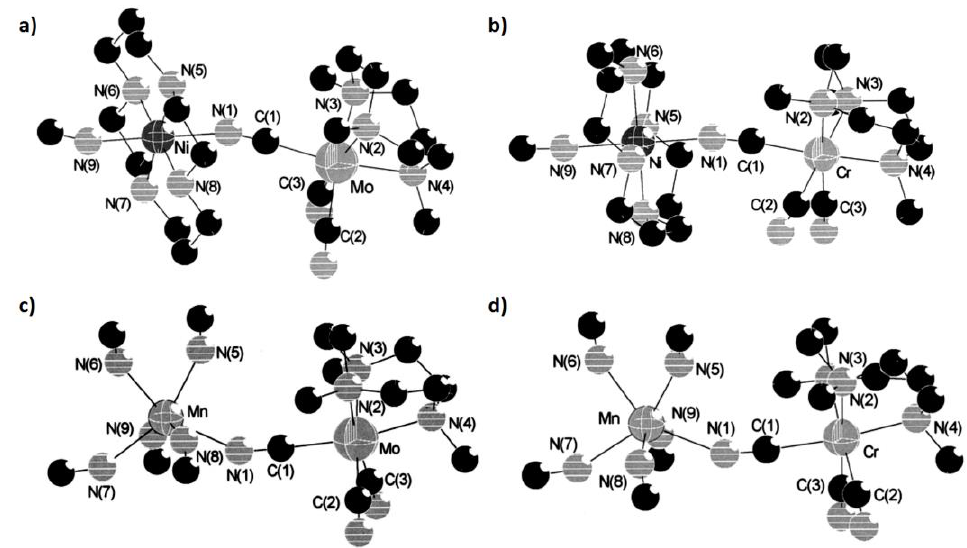
Figure 11. Structures of four model complexes marked A ( a ), B ( b ), C ( c ) and D ( d ). All hydrogen